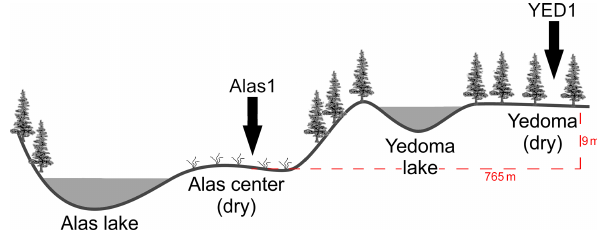
Figure 2. Setting of the drilling locations for the Alas1 and YED1 cores showing the distance and height difference between the lo- cations (vertical scale exaggerated). The terms “alas lake” and “Yedoma lake” are chosen following Ulrich et al. (2017a) in ac- cordance with the deposit type in which the thermokarst lakes are located; the Yedoma lake can also be called “dyede” due to its de- velopment stage following Crate et al.